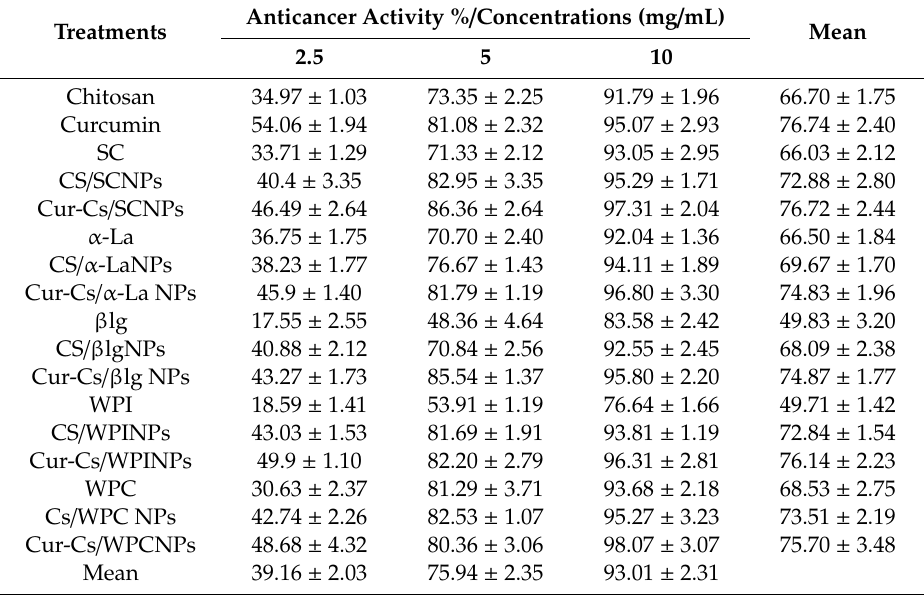
Table 3. Anticancer activity of di ff erent concentrations of native proteins, chitosan–milk protein nanocomposite and curcumin-loaded milk protein nanoparticles against HepG2 cell lines.